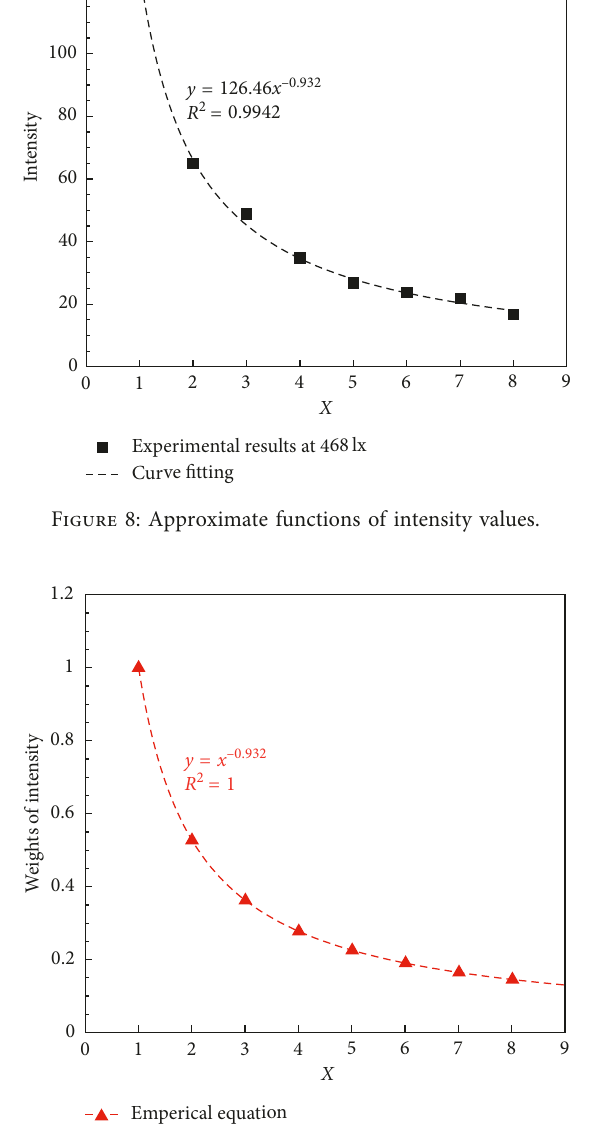
Figure 9: Intensity reduction caused by black body